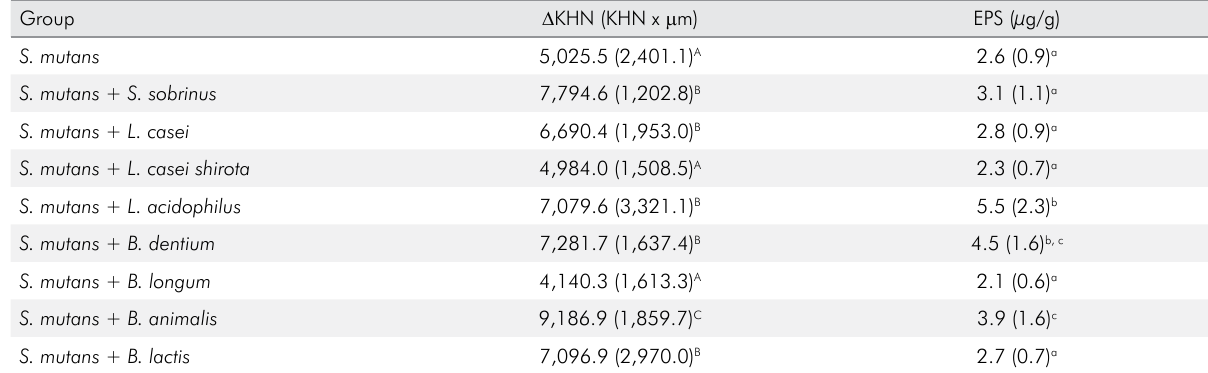
Table 1. Mean (standard deviation) of subsurface enamel hardness ( Δ KHN) and insoluble extracellular polysaccharides (EPS) measurements for the double